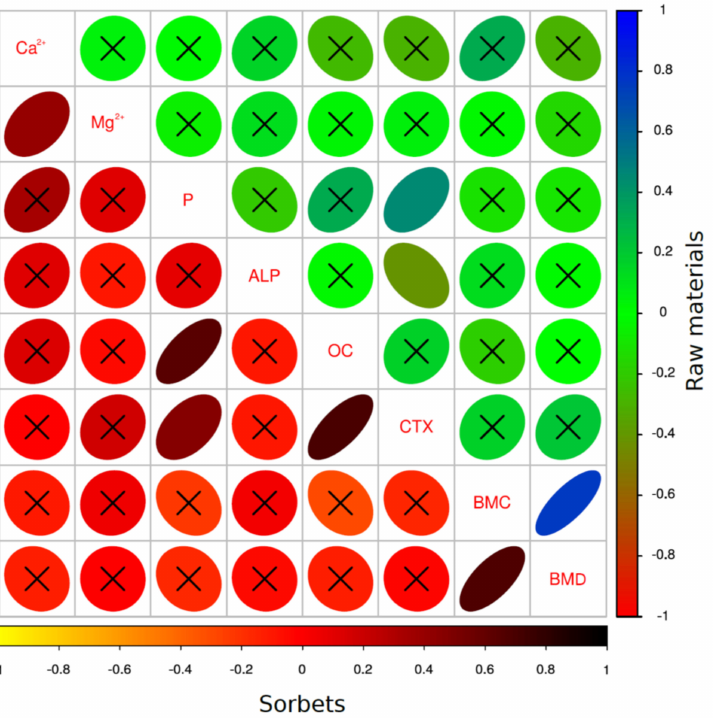
Figure 4. Correlations between examined parameters in terms of dependence on form of addition of fructan (raw material or sorbet) to the rats’